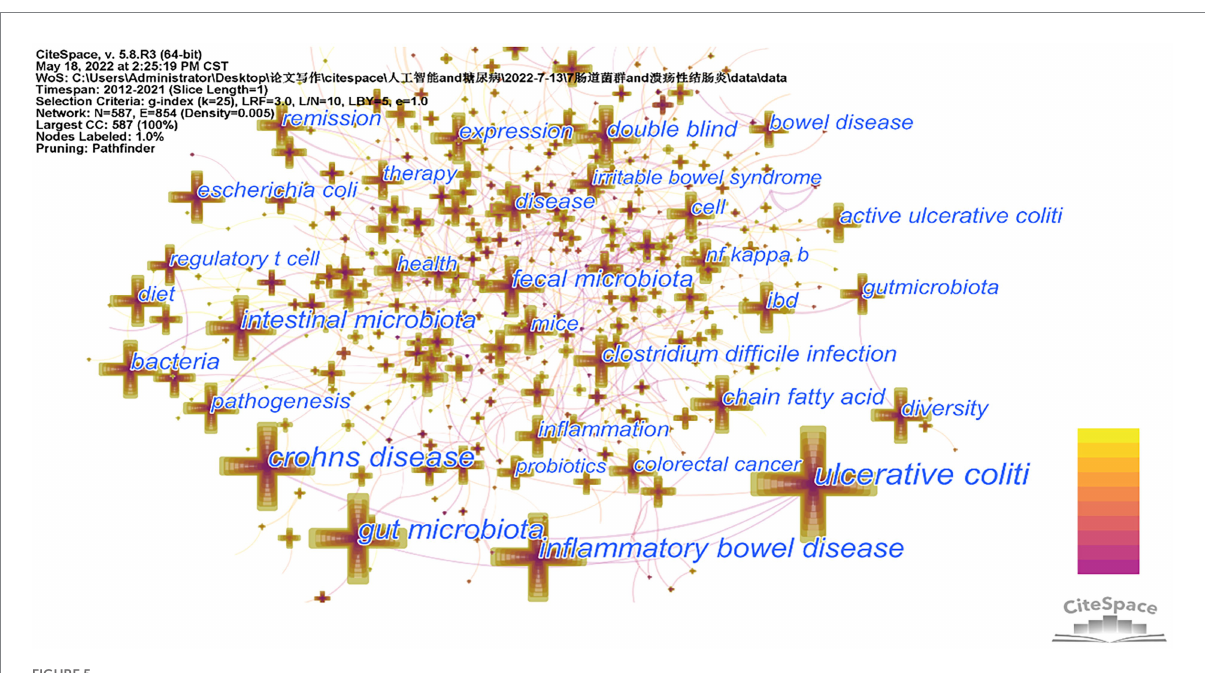
FIGURE 5 Keyword co-occurrence